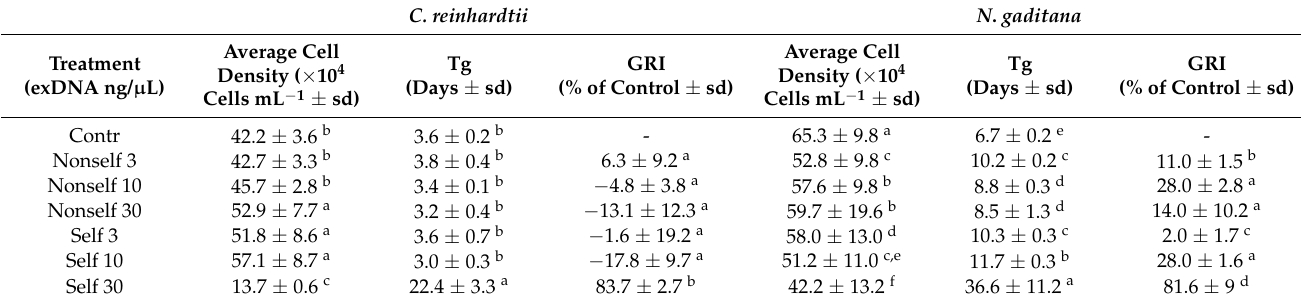
Table 1. Microalgae growth parameters (index). Average cell density ( × 10 4 cells mL − 1 ), generation time (Tg), and growth rate inhibition measured as the % with respect to the control (GRI (%)) of C. reinhardtii and N. gaditana at 168 h post treatment (hpt), at different concentrations of nonself- and self-exDNA; sd: standard deviation. Different letters indicate statistically significant differences between treatments in each column.